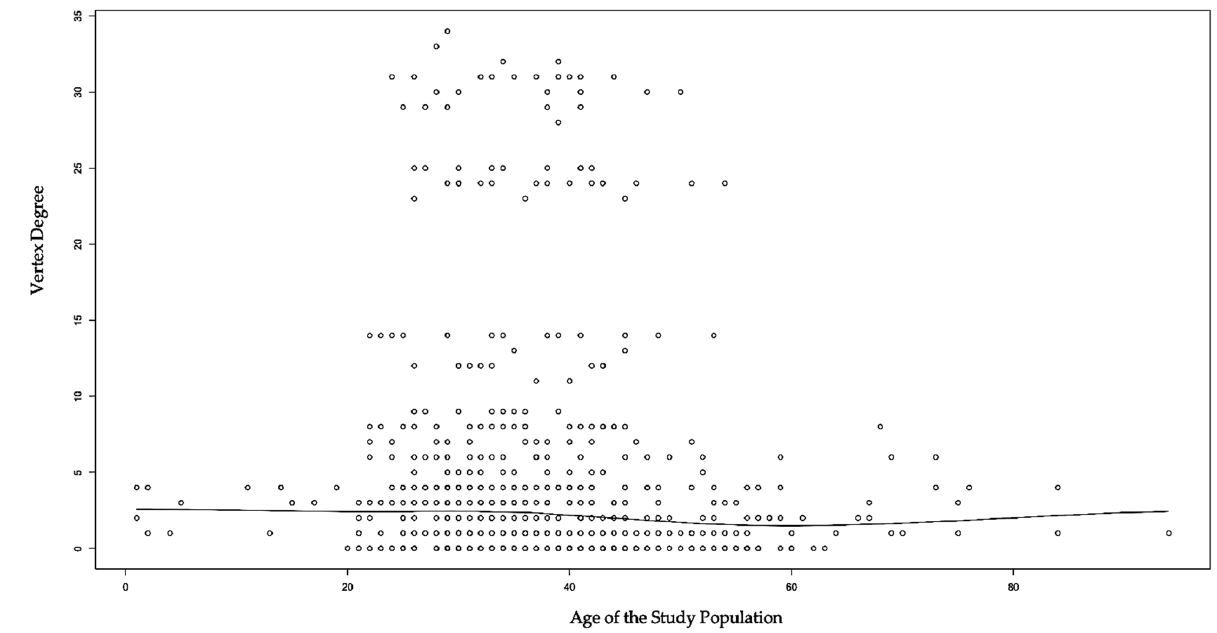
Figure 4. Association Between Age of the Study Population and Vertex Degree.